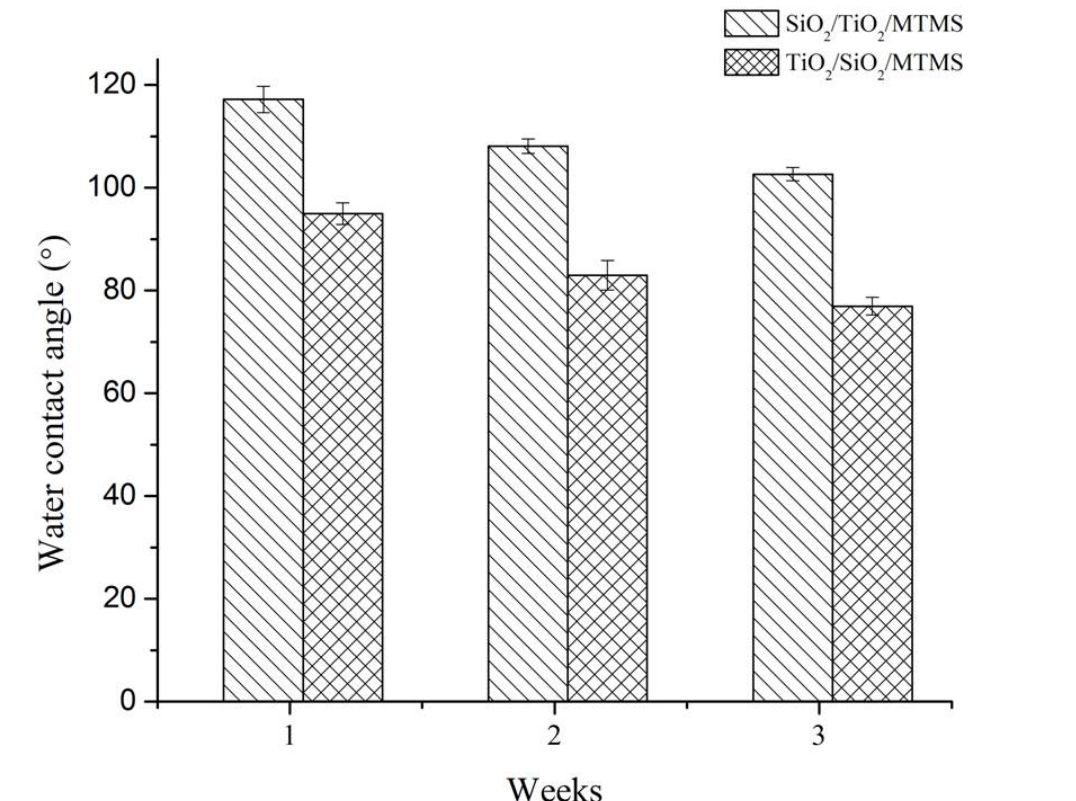
Figure 5: The water contact angle of STM and TMS coated glass under outdoor